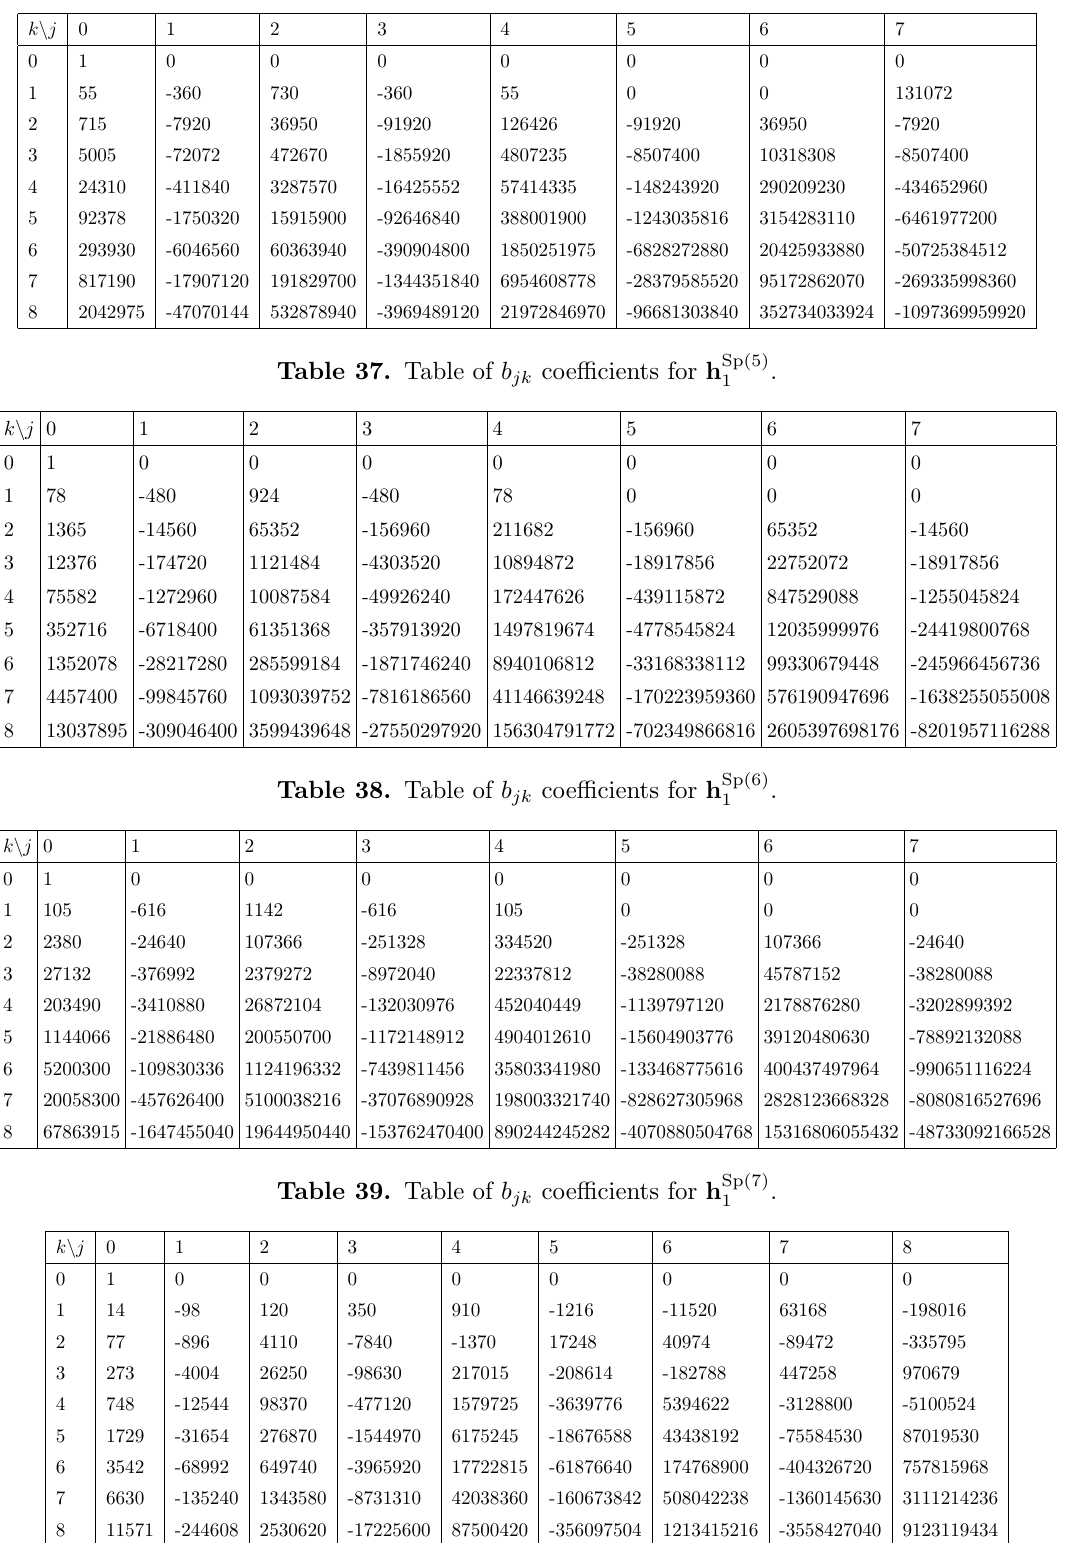
Table 40. Table of b jk coe(cid:14)cients for h G 2